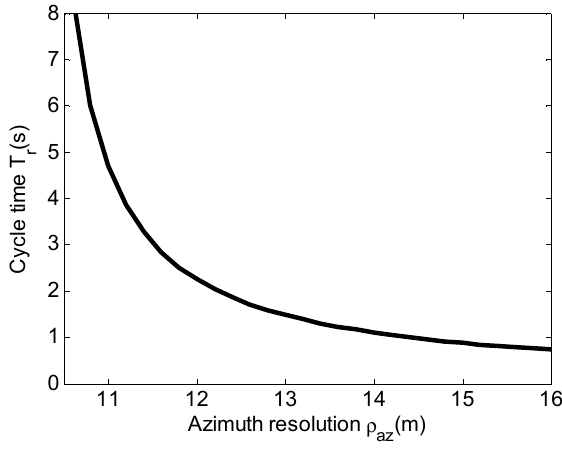
Figure 7. The relationship between cycle time and azimuth